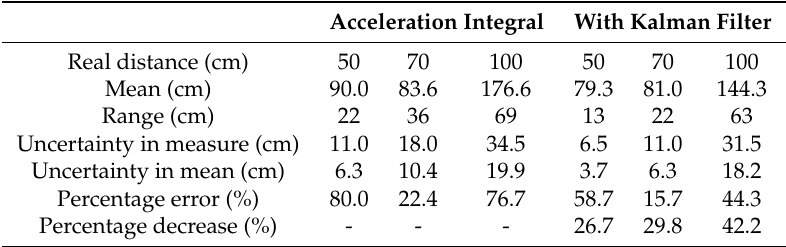
Table 4. Displacement along the xy-plane measured with the smartphone.